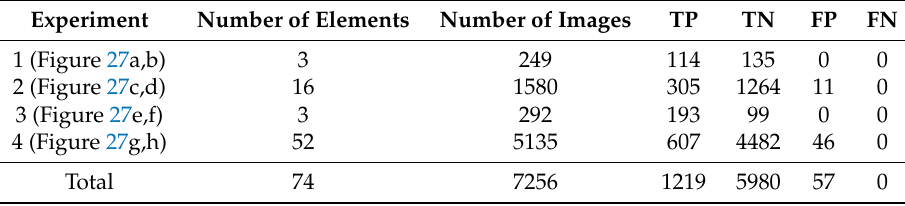
Table 6. Result of the evaluation (TP, TN, FP, and